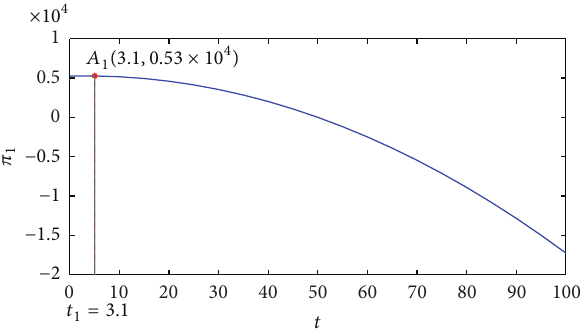
Figure 2: The change of the LSI’s profit with 𝑡 , when 𝐶 2 = 1.5 .